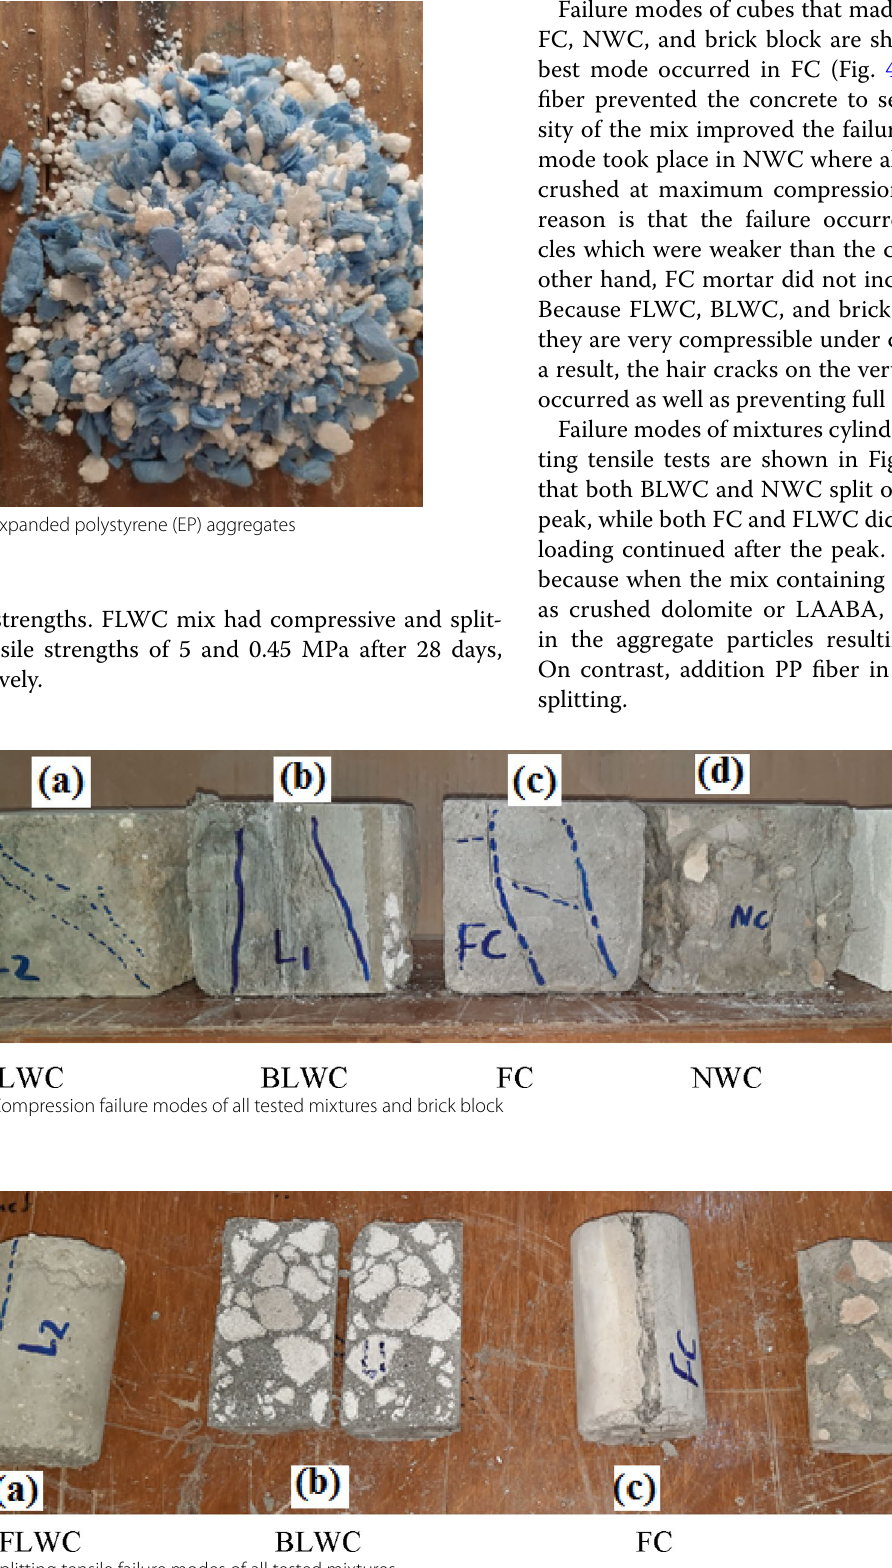
Fig. 5 Splitting tensile failure modes of all tested